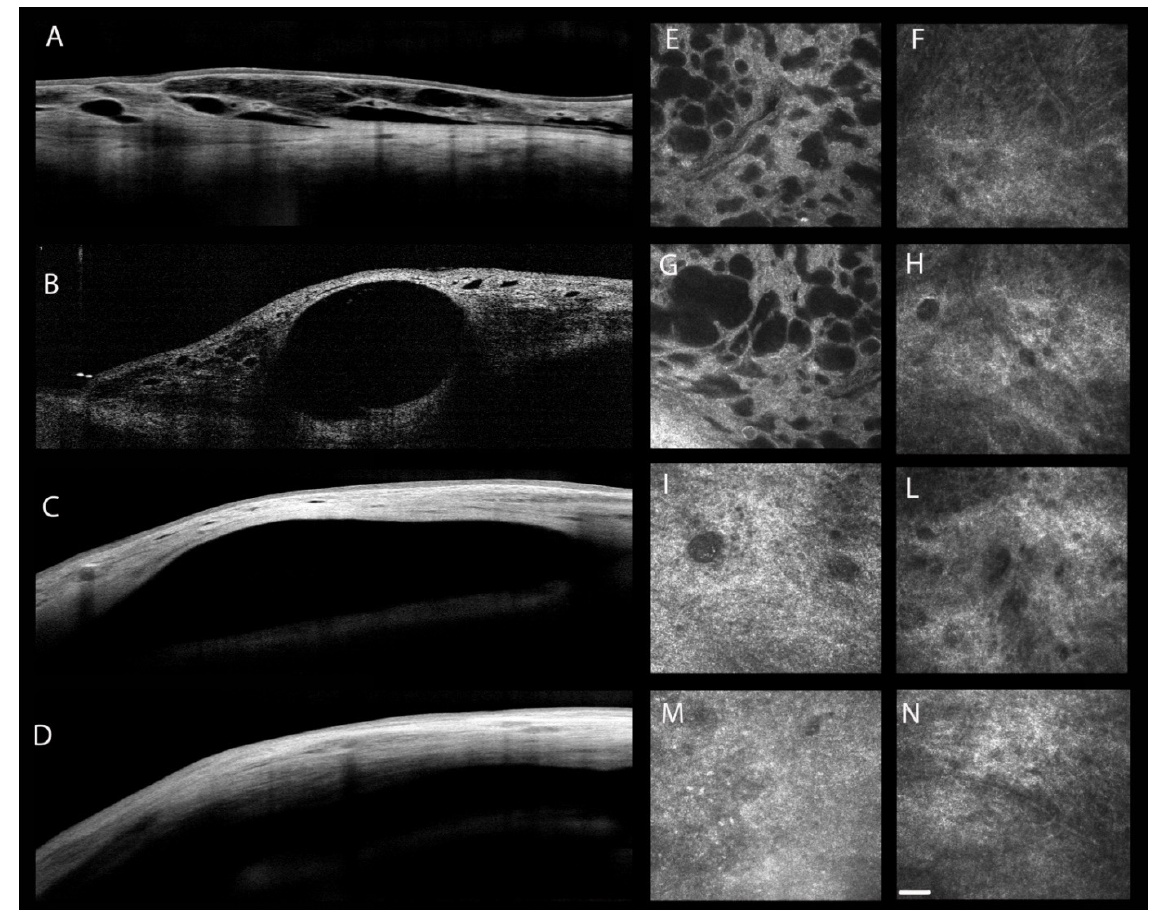
Figure 3. AS-OCT and IVCM conjunctival bleb features after glaucoma filtration surgery. ( A – D ) Filtration bleb imaged by AS-OCT. Diffuse ( A ) or cystic ( B ) filtration bleb after completely successful trabeculectomy, showing numerous, differently sized hypo-reflective spaces filled with aqueous humor; incapsulated ( C ) and flat ( D ) filtration bleb after a failed trabeculectomy without evidence of hypo-reflective intra-bleb wall spaces. ( E – N ) Bleb-wall imaged by IVCM. In diffuse ( E , F ) or cystic ( G , H ) functioning filtration blebs, the bleb-wall epithelium ( E , G ) shows several microcysts with a loosely arranged stroma ( F , H ), indicating a good aqueous humor percolation and a minimal hydraulic resistivity through the bleb-wall layers. Opposite features are present in incapsulated ( I , L ) or flat ( M , N ) non-functioning filtration blebs: the bleb-wall epithelium ( I , M ) shows rare microcysts, whereas the stroma ( L , N ) appears densely arranged. These features indicate an inefficient aqueous humor percolation through the bleb-wall layers. Bar represents 50 µm.